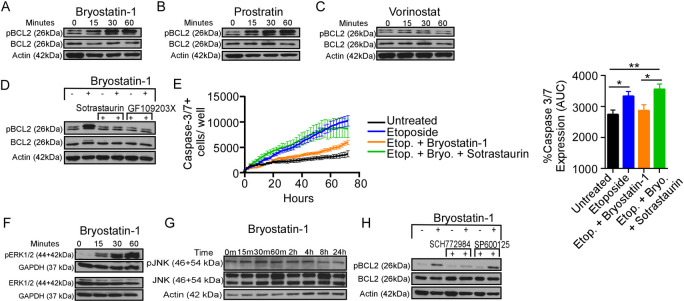
PKC agonists induce ERK-dependent BCL2 phosphorylation.A-C) CD4 T cells treated with 3 different LRAs (A: bryostatin-1; B: prostratin; C: vorinostat) were assayed for phospho-S70-BCL2 and total BCL2 by western blot. D) Cells treated with PKC inhibitors GF109203X (GF) or Sotrastaurin prior to treatment with bryostatin-1 were assessed for phosphorylation of BCL2 S70. E) CD4 T cells were treated with the PKC inhibitor sotrastaurin prior to treatment with bryostatin-1 and etoposide (ETP). Cells were tracked over 3 days for active caspase 3/7. Graphs show mean (SD) area under the curve for each treatment. * p<0.05; ** p<0.001. F-G) CD4 T cells treated with bryostatin-1 over an hour or over 24 hours were probed for phospho-ERK1/2 (F) or phospho-JNK (G). Western blots showed increased ERK1/2 phosphorylation but not JNK phosphorylation. H) CD4 T cells treated with ERK1/2 inhibitor SCH772984 or JNK inhibitor SP600125 (SP) and bryostatin-1 showed loss of BCL2 phosphorylation with SCH772984 but not SP600125.